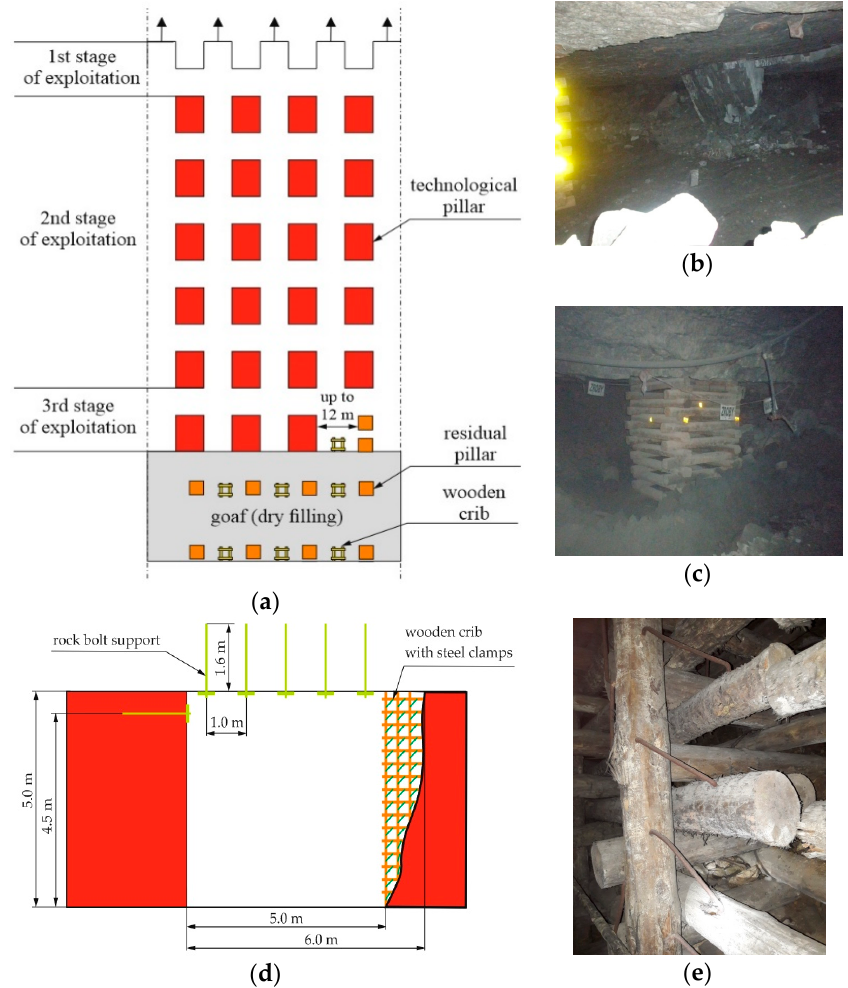
Figure 2. Cribs in Polish ore mining: ( a ) Support of the widened room in the room and pillar method with roof sag in the Legnicko-Głog ó w Copper District in Poland (the use of cribs in the phase of cutting technological pillars); ( b ) Residual pillar; ( c ) General view of crib; ( d ) Support of the widened room in zinc and lead ore mining in Poland; ( e ) Joining beams with steel clamps.